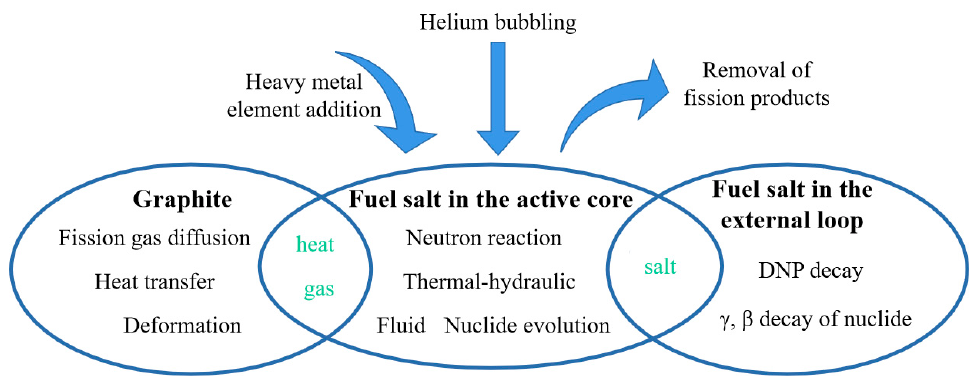
Figure 3. Multi-physics mechanisms in MSRs.